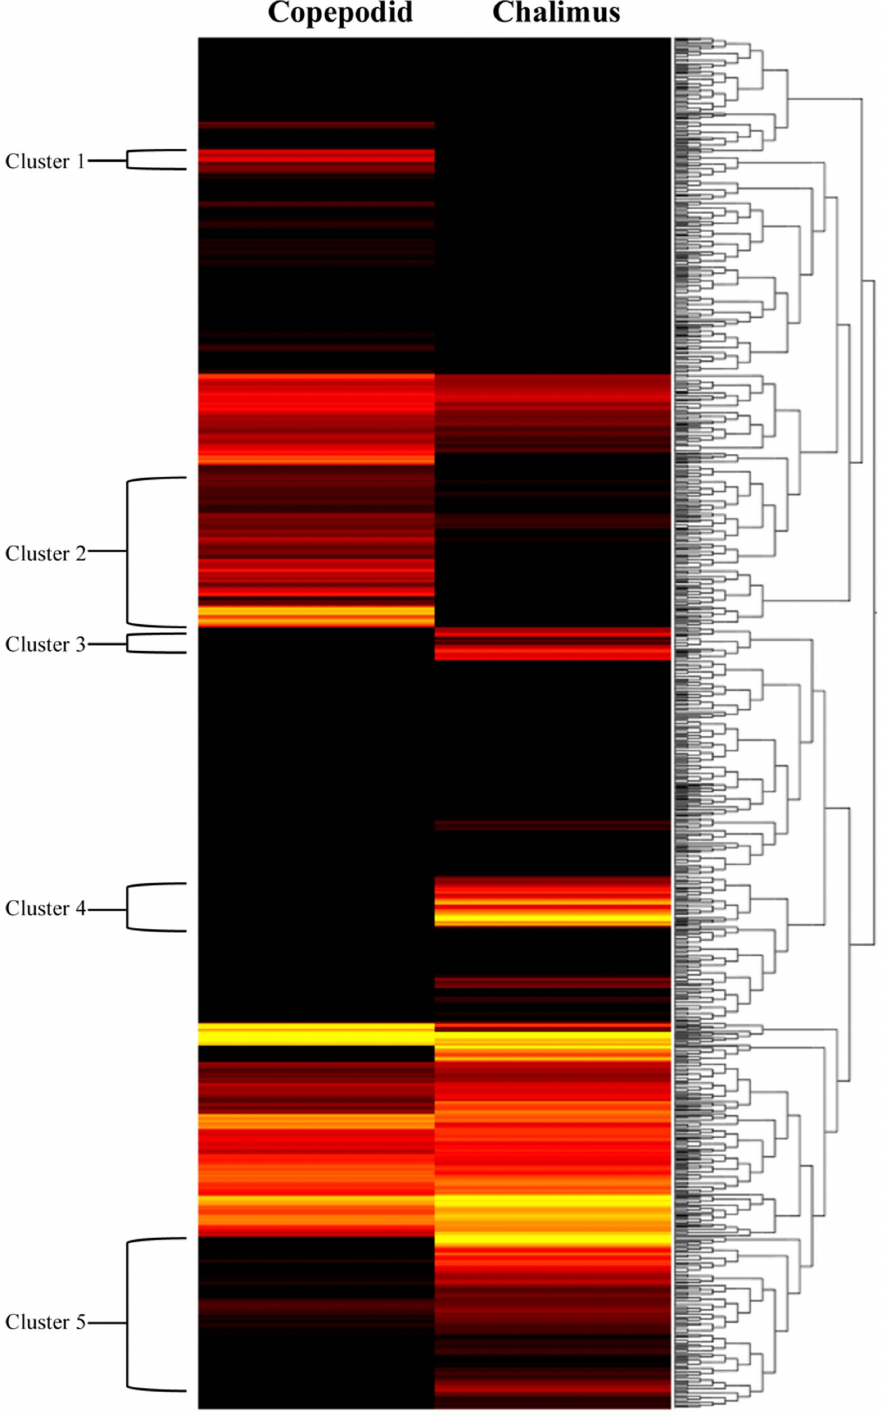
Figure 5. Clusters of gene expression levels between copepodid and chalimus stages of C. rogercresseyi . Dendrograms of the transcription patterns were estimated for 83,444 contigs generated by de novo assembling. The bar color reflects the gene expression level from black (low), red (medium) to yellow (high). Contig annotations of these 5 clusters are listed in Table S3. doi:10.1371/journal.pone.0092239.g005 mapped reads (RPKM) was obtained with the same software [28]. differences between developmental stages, RNA-seq analyses were This normalized the number of reads to the size of assembled performed for nauplius I, nauplius II, copepodid and chalimus, contigs and allowed for assessing the transcripts that were and female and male adult stages. Following this, the transcripts overexpressed among different groups. In order to identify that were differentially expressed in comparison to normalized